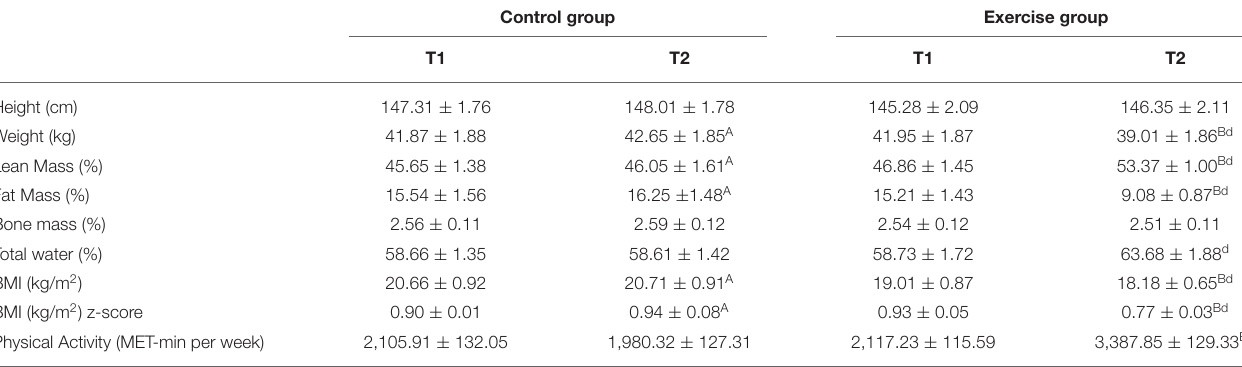
TABLE 1 | Anthropometric characteristics and results of the International Physical Activity Questionary in the last 7 days from the control and exercise groups.